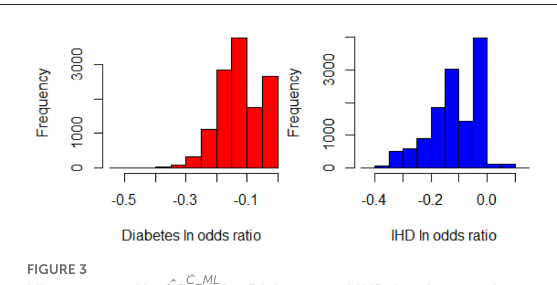
FIGURE3 C _ ML Histograms of ln ˆ OR i for Diabetes and IHD, leaving out those individuals who are already Very Active in the target population (N =